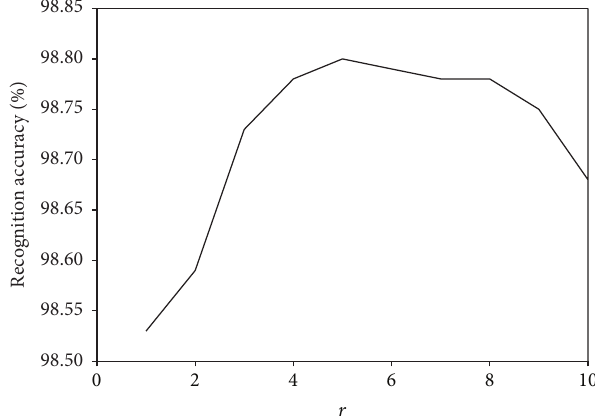
Figure 13: Recognition accuracy of MDGPP versus varying param- eter 𝑟 on the AR